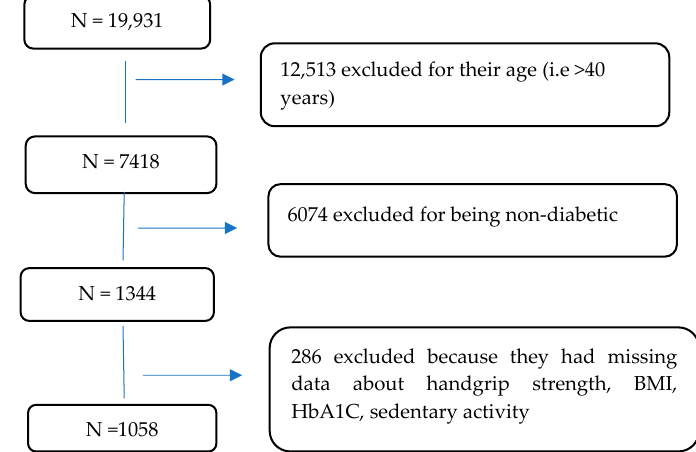
Figure 1. Flow chart of the study population .